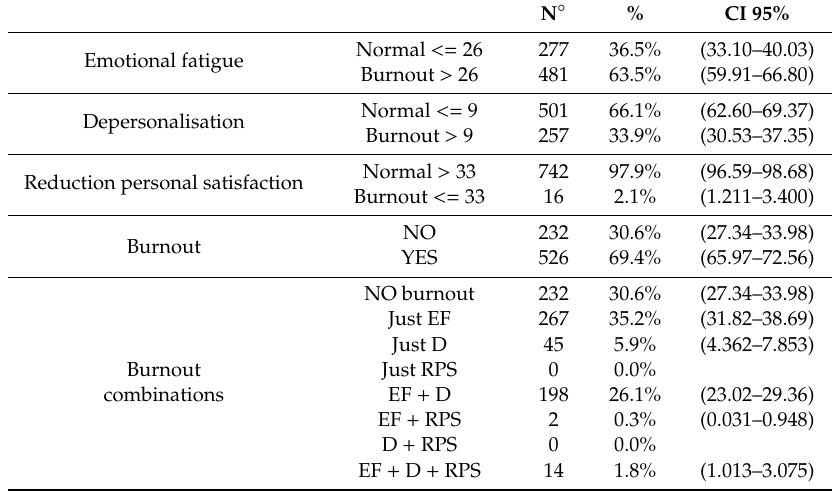
Table 2. Prevalence of burnout.